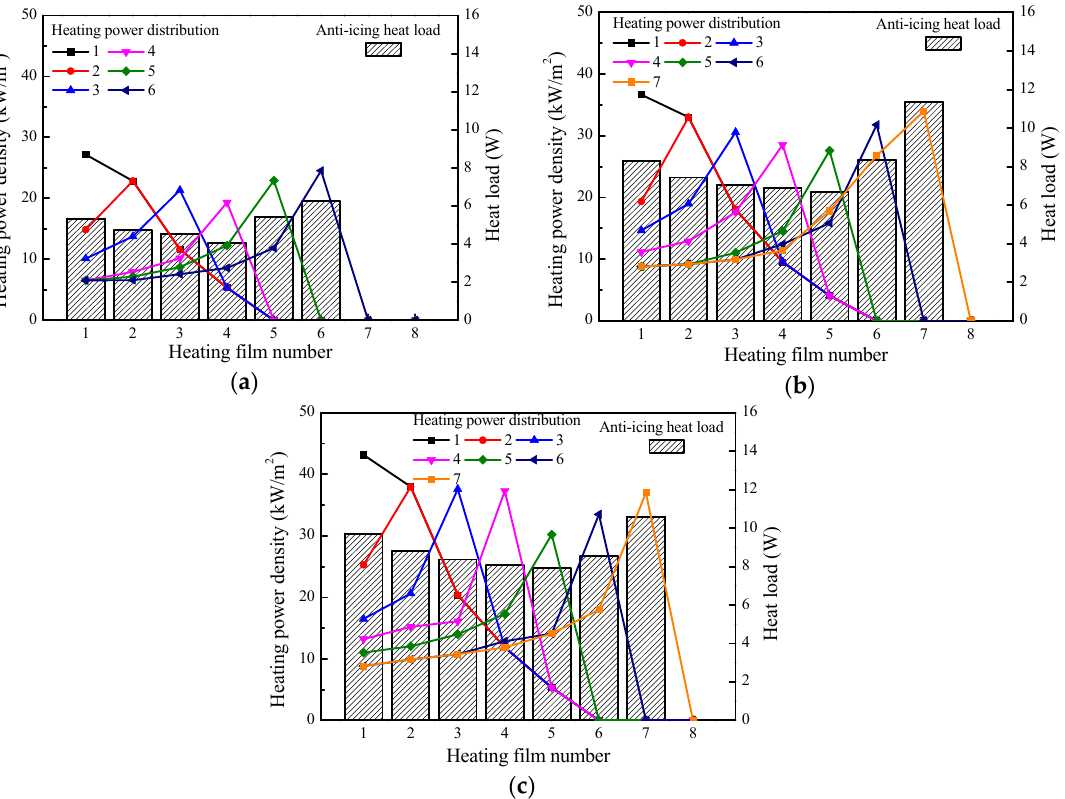
Figure 12. Heating power distributions and the anti ‐ icing heat loads with different runback water locations: ( a ) Case 1; ( b ) Case 2; ( c ) Case 3.